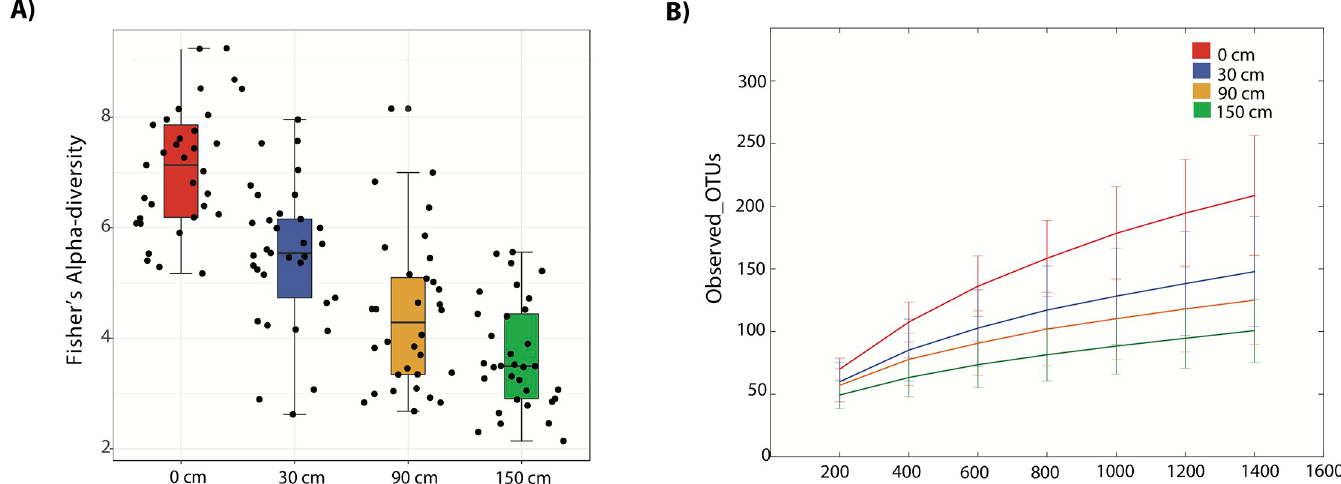
Fig 2. Comparison of alpha diversity at different sampling height of the OR for all walls combined. Panel A shows Fisher’s alpha diversity for different samples (black circles) through the four sampling height categories (Colored boxes). Diversity values were significant among wall height ( P = 2.0048e-21; F-value: 50.06). Panel B shows the Rarefaction curves of observed OTUs by sampling category with a maximum sequencing depth of 1400 reads. P -values based on Monte Carlo permutations are depicted in the table inside the rarefaction curves.